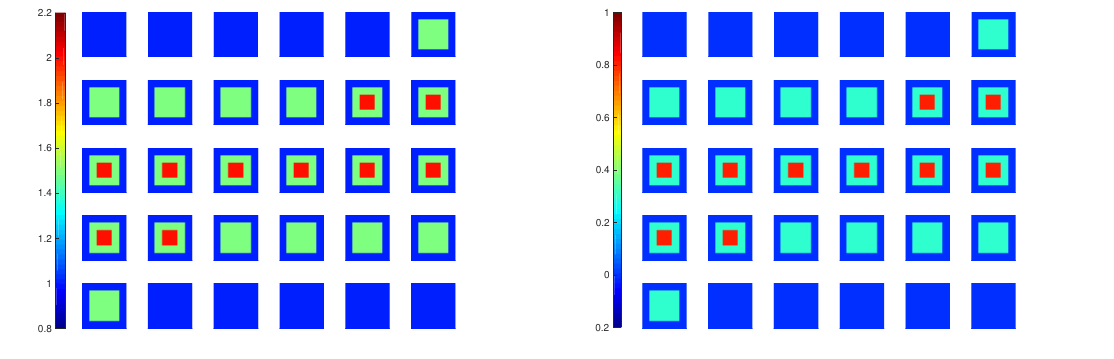
( c ) Imaginary part of the true profile of the coated cube. Figure 4. Coated cube used in Example 1 .